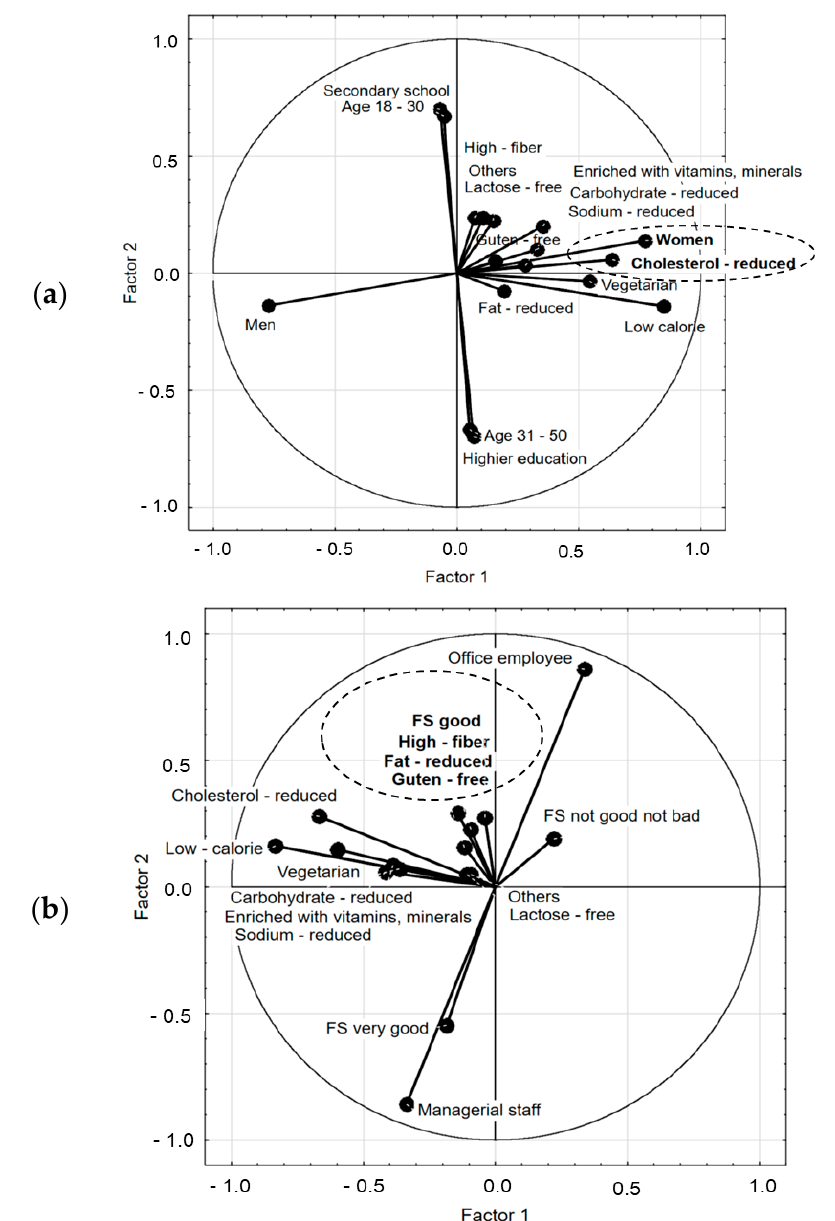
Figure 3. ( a , b ) The relationship between the consumer expectation toward the staff canteen meals and the consumer sociodemographic factors: ( a ) gender, age, education; ( b ) position and financial status of consumers; FS—financial status.